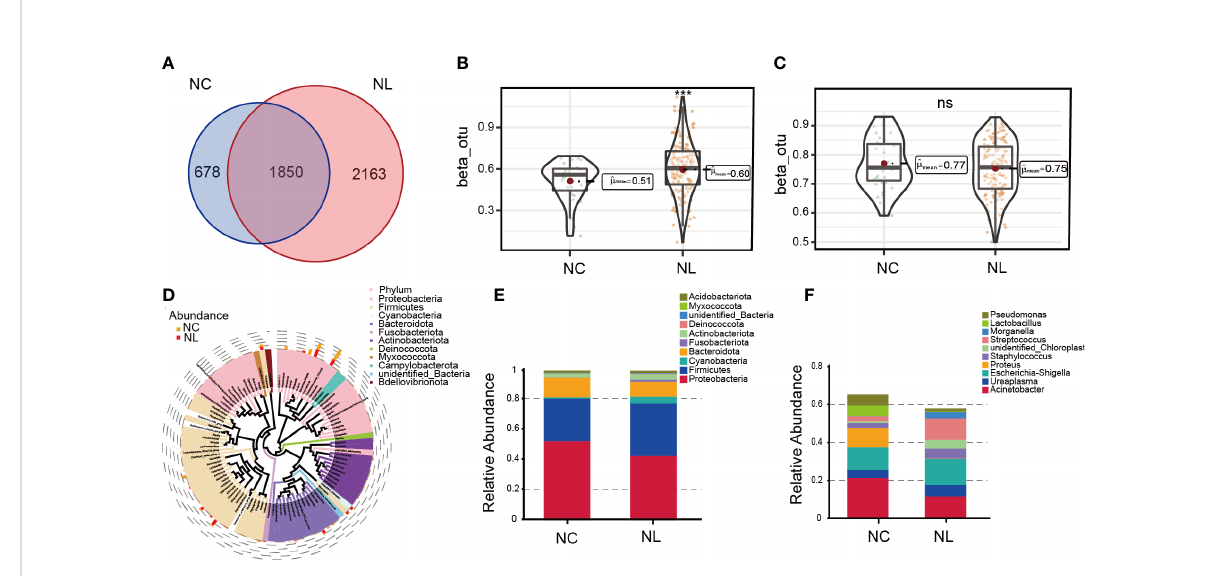
FIGURE 1 Urinary microbiome diversity and structure analysis. (A) Operational taxonomic units (OTUs) between the normal control (NC) and nephrolith (NL) groups. (B, C) Comparison of b diversity based on weighted and unweighted UniFrac distance between the NC and NL groups. (D) Cladogram presenting phylogenetic distribution of microbiota between the NC and NL groups. (E) Relative abundances of bacterial phyla between NC and NL groups. (F) Relative abundances of bacterial genera between NC and NL groups. ***P < 0.001. ns, no signi fi